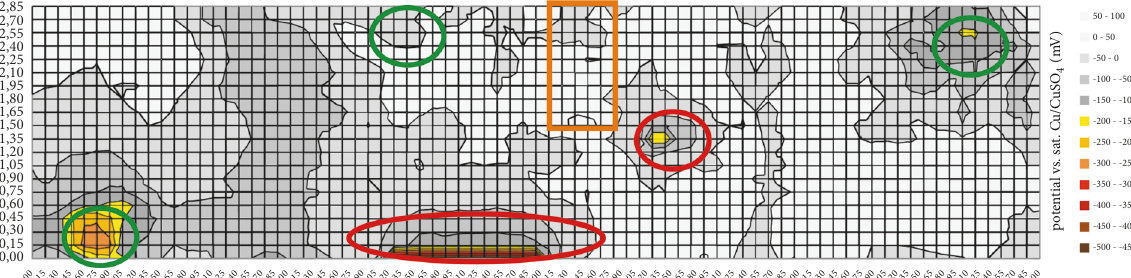
Figure 9: Potential mapping results of the large-scale specimen at a nonmoistened surface—three anodes, the galvanized stairway, connected floor drain, and an epoxy coated